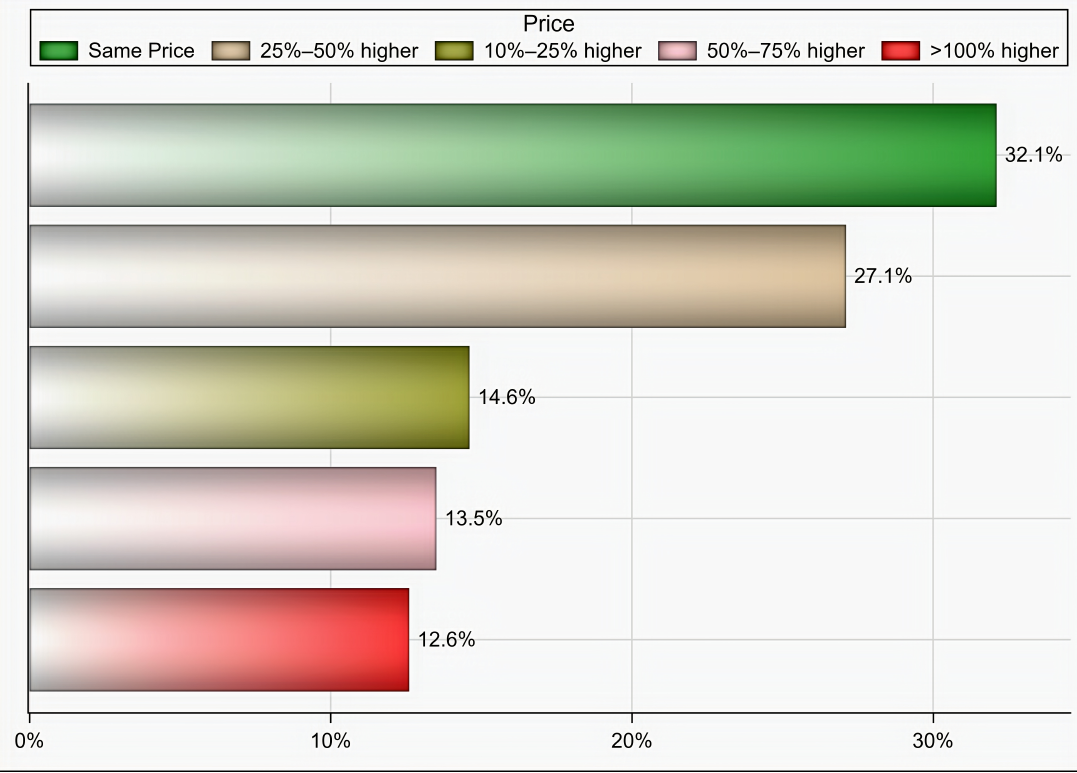
Figure 4. The impact of COVID-19 on prices of PPE in short supply based on participants’